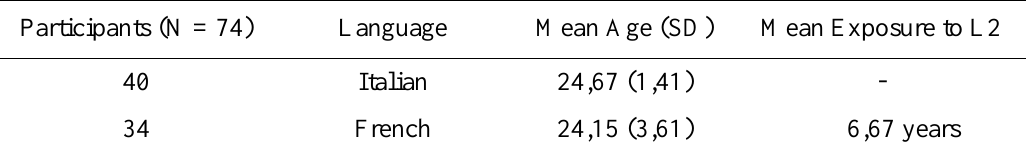
Table 4. L1 and L2 Italian speakers’ demographic